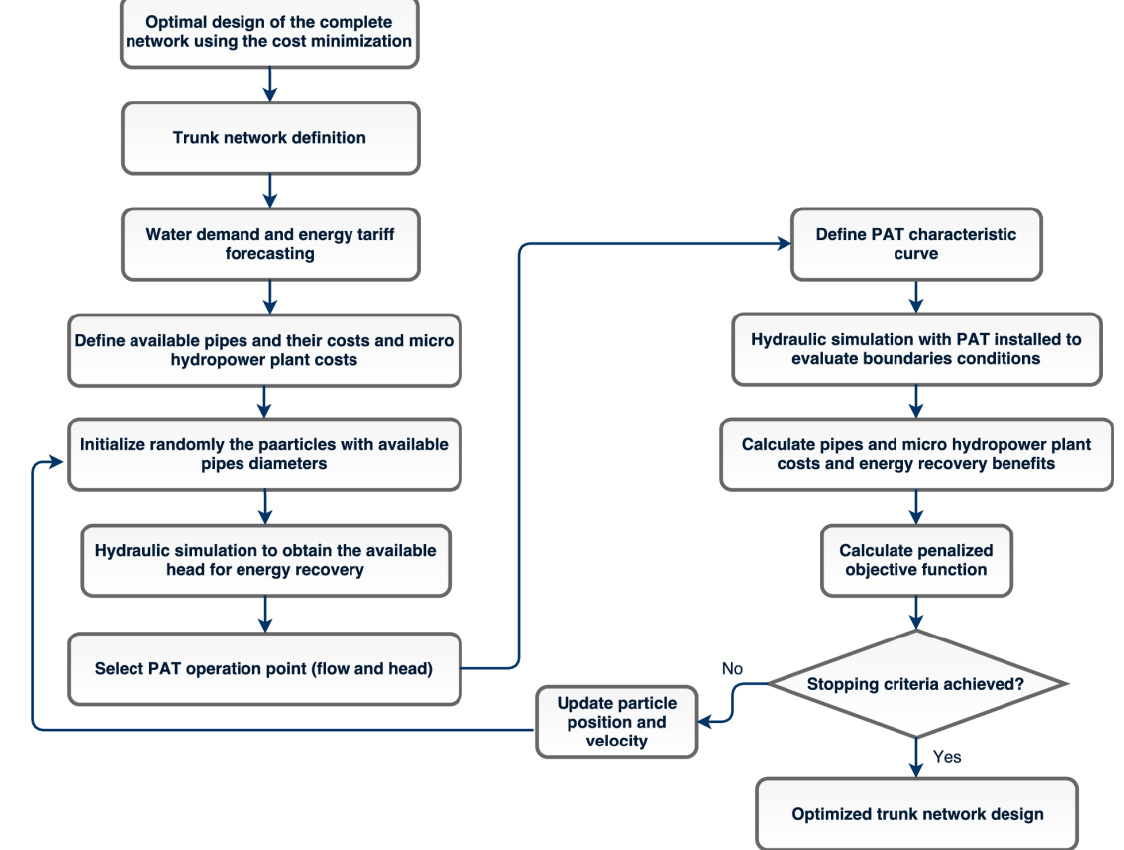
Figure 5. Flowchart of Trunk Network (TN) design with PAT selection.